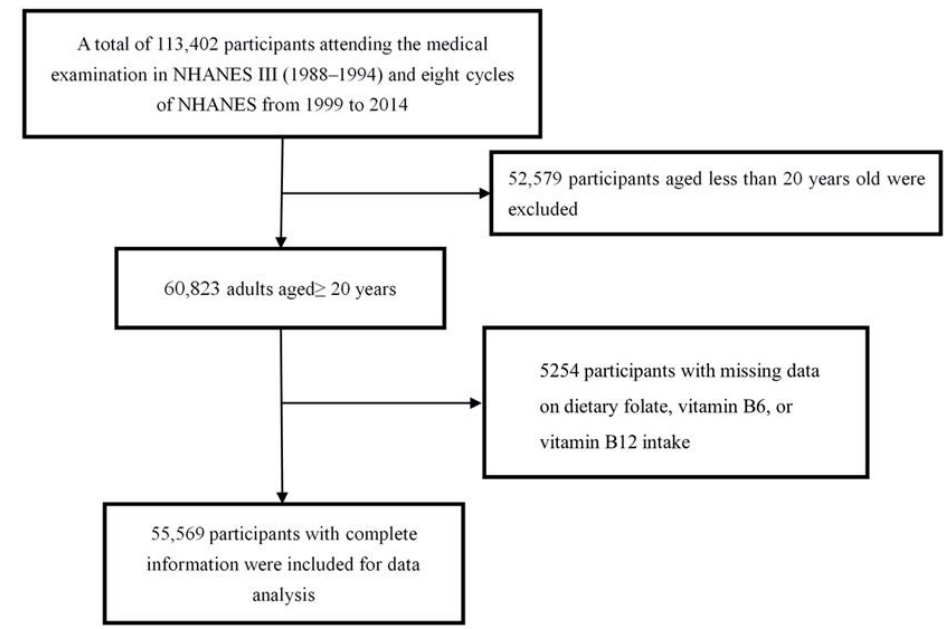
Figure 1. Flowchart of participant selection.